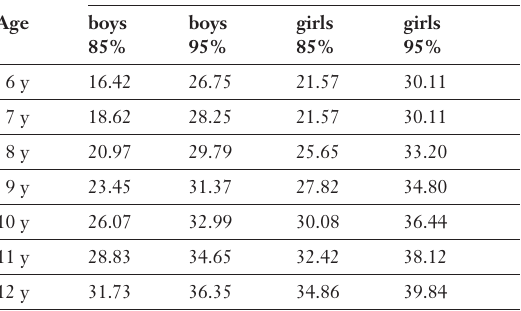
Table 1 The 85 th and 95 th percentile cut-offs for body fat percentage by gender calculated fromfour measure- ments of skinfold- thickness in a na- tional sample of 6–12 year old Swiss